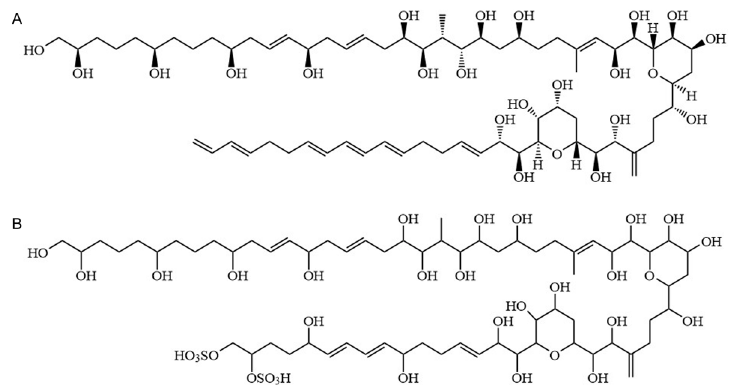
Figure 1. Chemical structures of amphidinol 3 (AM3, A ) and amphidinol 25 (AM25, B ).